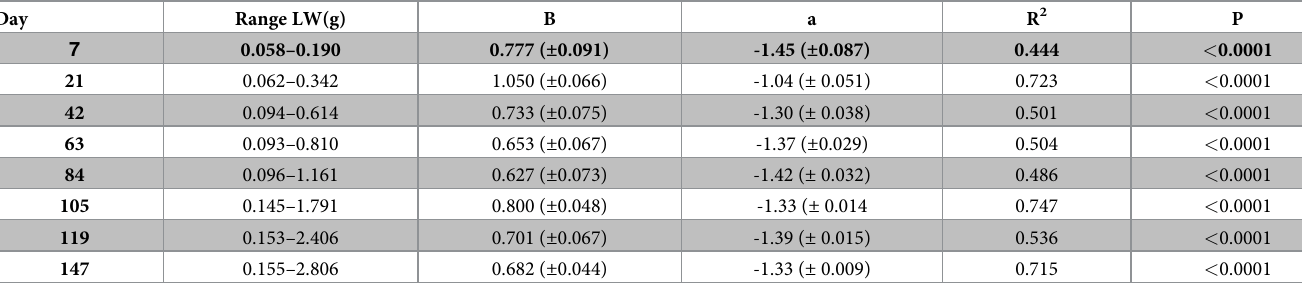
Table 2. Inter-individual allometric relationships in different growth phases.